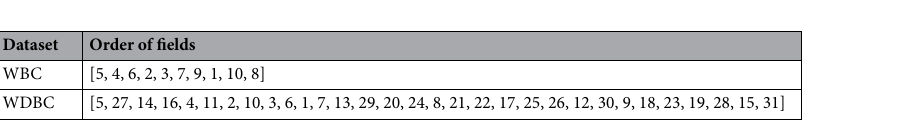
Table 9. Order of fields based on minimization of total co-variance of adjacency matrix.